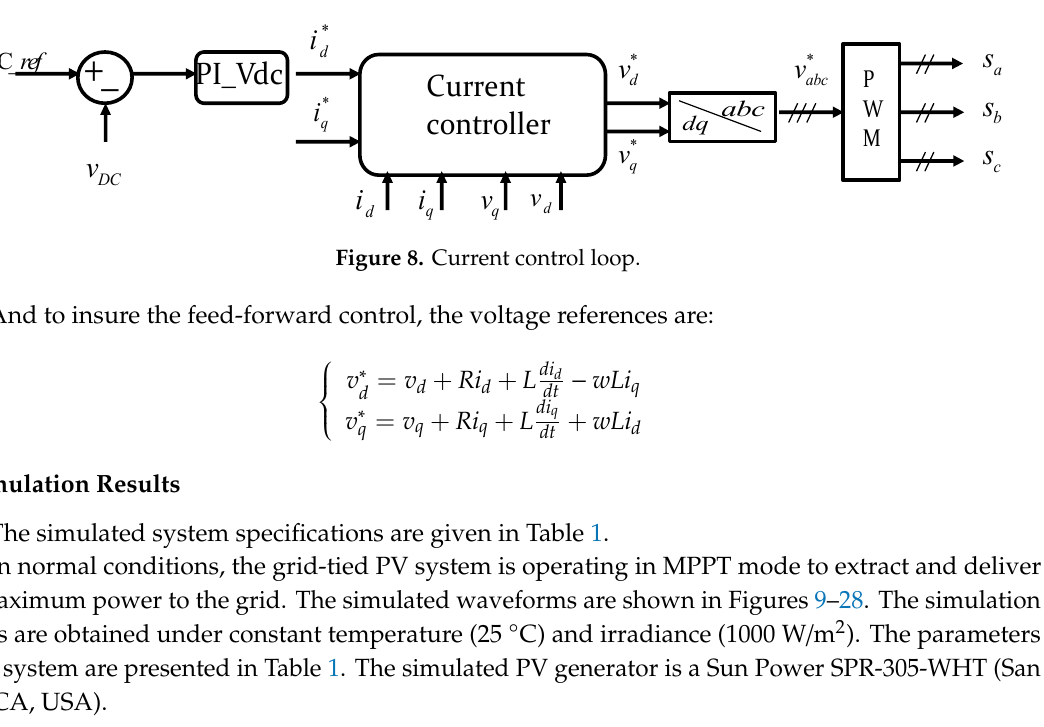
Table 1. Parameters of the system.